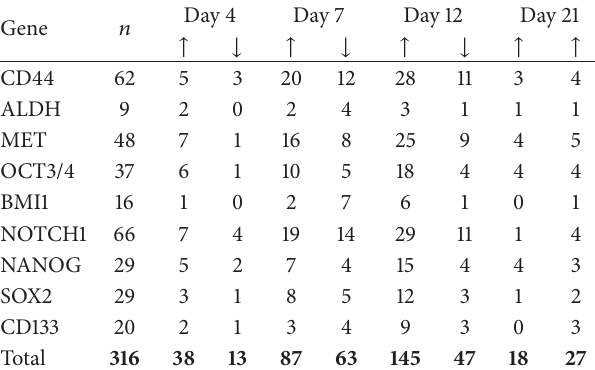
Using Partek Genomics software and Pathway Studio, genes that were differentially expressed at a minimum of one time point after radiation with